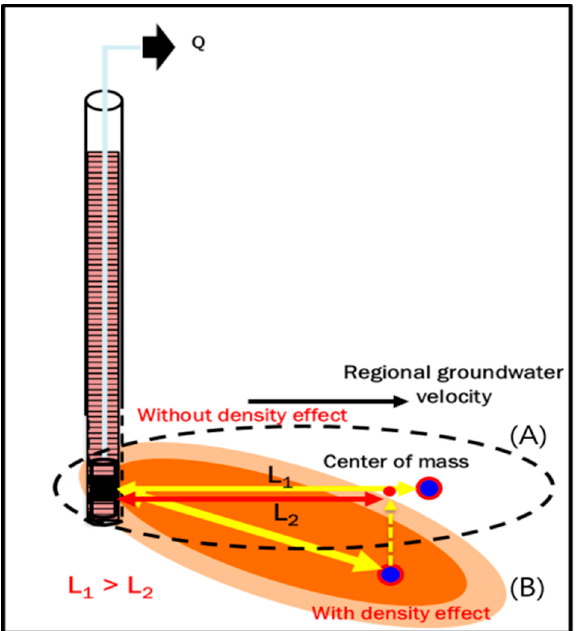
Figure 7. The conceptual model of the migration of tracer plume under the no-density effect condition and the density-effect condition (L 1 : horizontal distance of no-density case, L 2 : horizontal distance of density case).